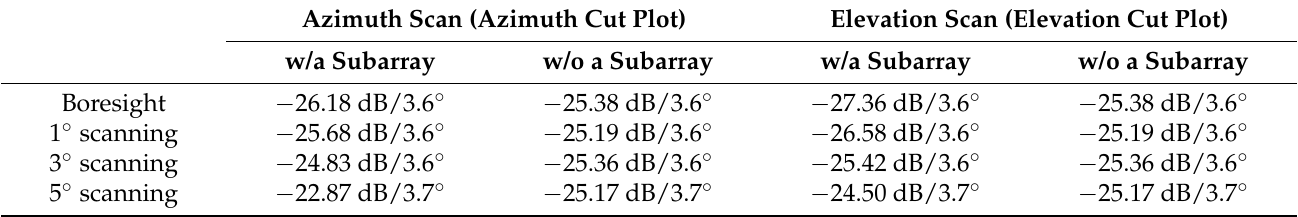
Table 1. Comparative analysis of SLL/HPBW changes according to the beam-steering angle at 30 GHz (w/a subarray (96 TRMs) vs. w/o a subarray (576 TRMs)).